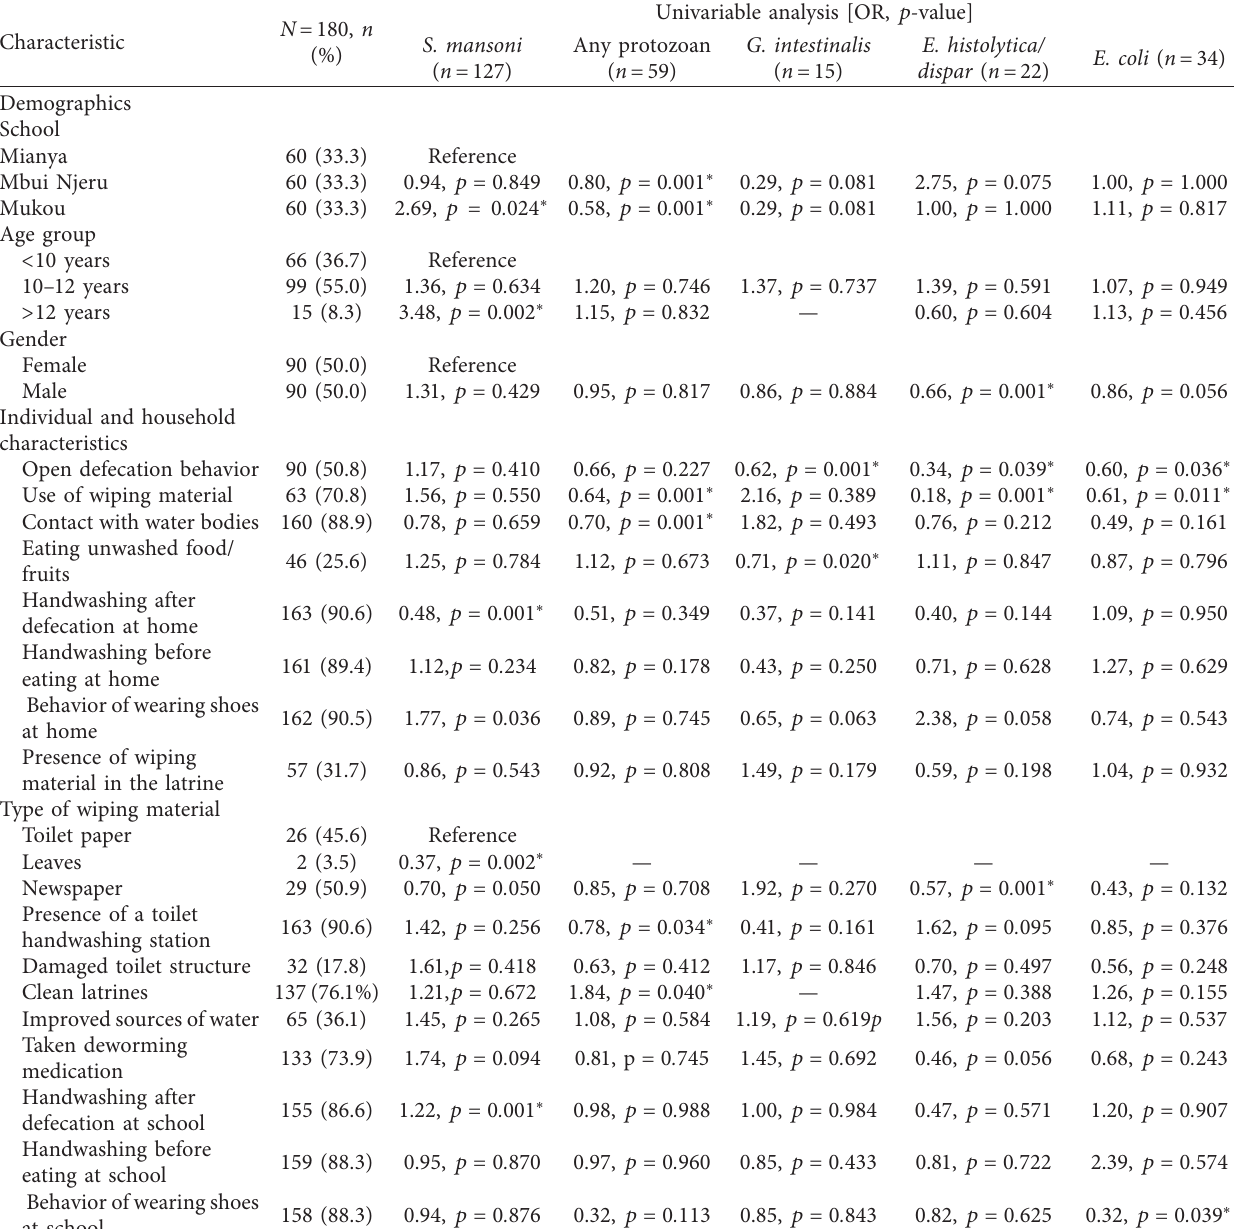
Table 2: Univariable analysis of risk factors of S. mansoni and intestinal protozoa infections.